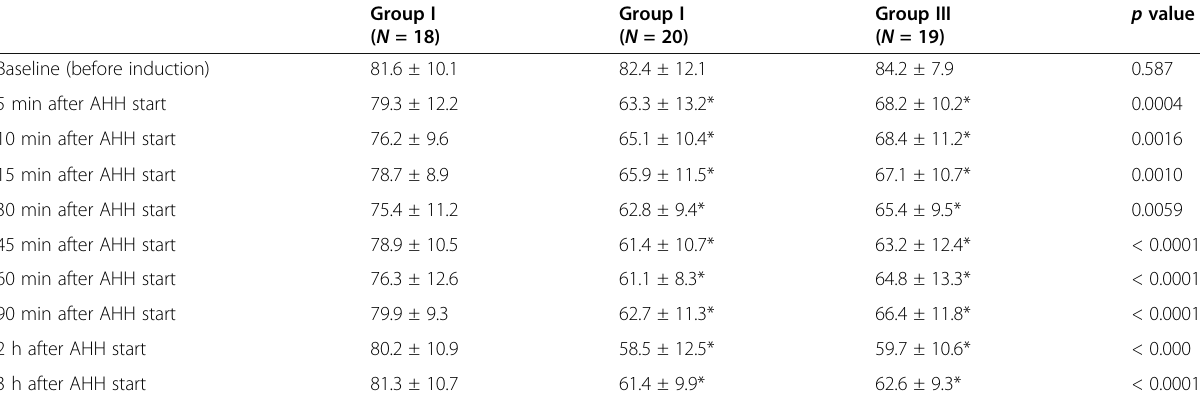
Table 6 Heart rate in the three study groups